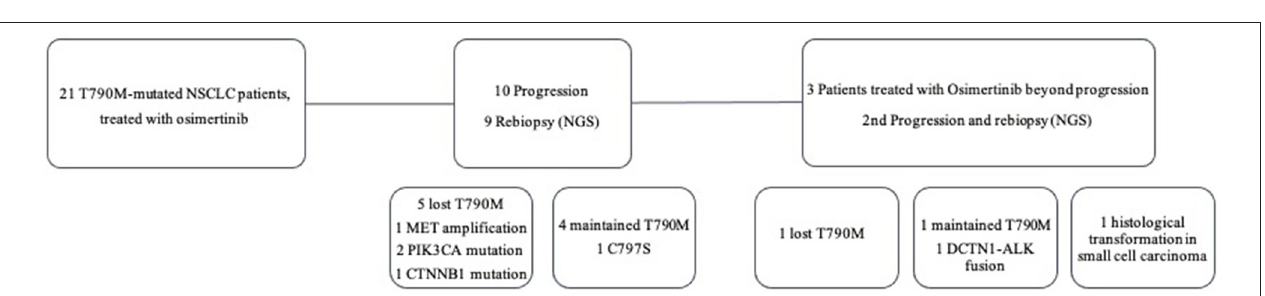
Comprehensive NGS panels help to define the genomic diversity of resistance mechanisms and are particularly important in this setting, where there is no single alteration to